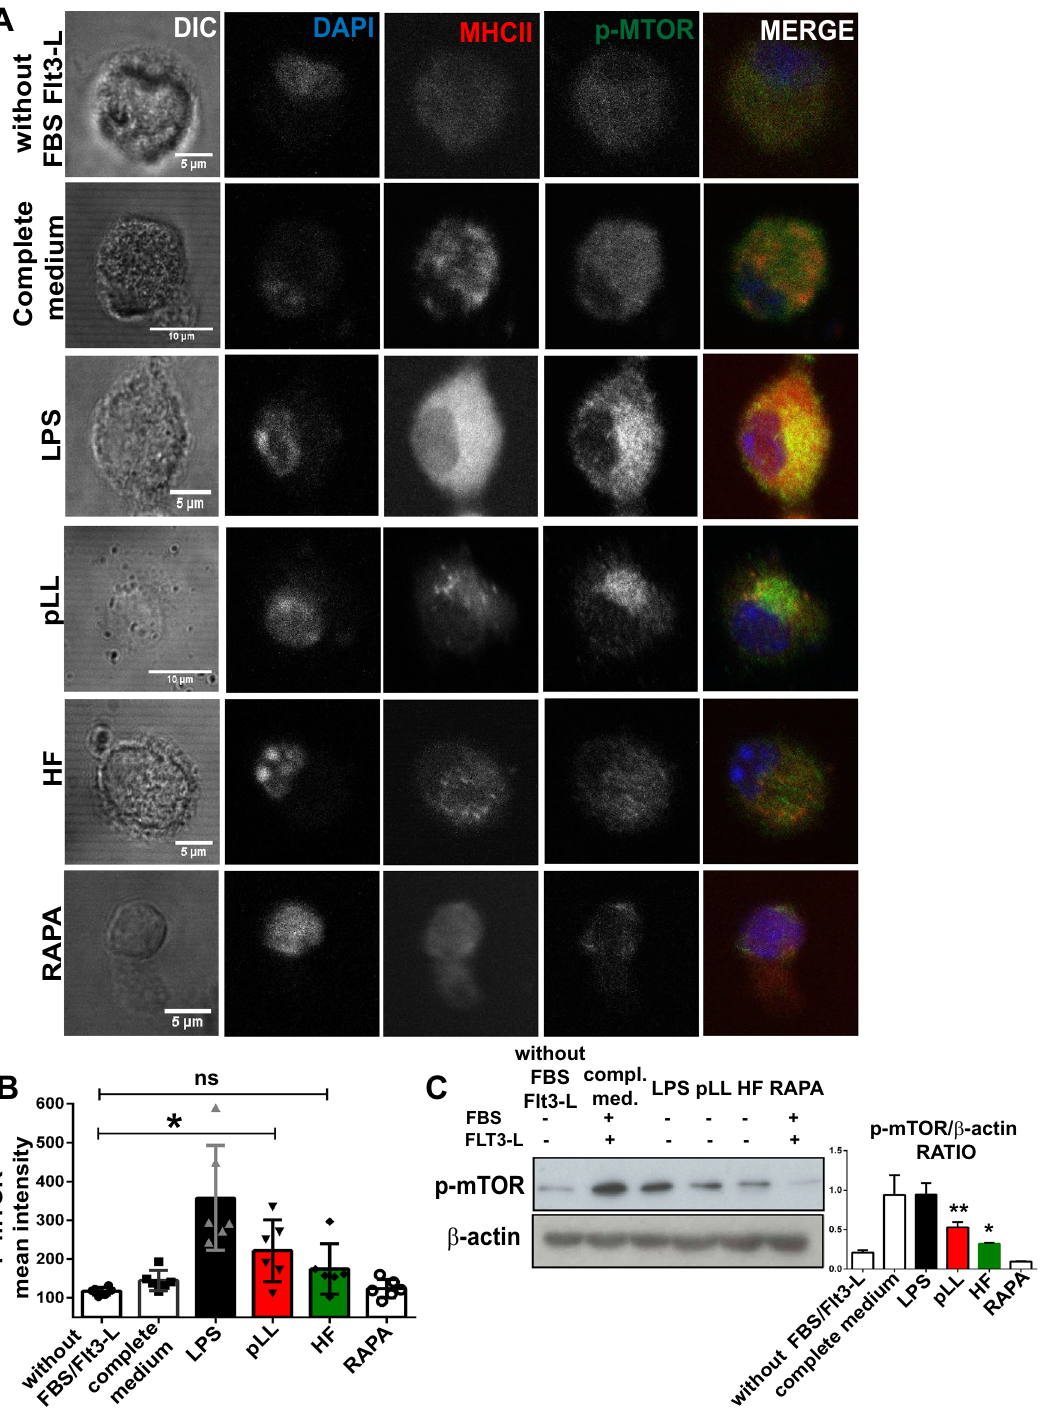
Figure 5. Purified laminar layer from Echinococcus granulosus induce the activation of mTOR complex. ( A ) BMDCs (1 × 10 6 /ml) were cultured in complete medium without FBS/Fl3T-L or stimulated for 18 h with 100 ng/ml LPS, 20 μg pLL or 5 μg HF in presence or absence of 20 nM rapamycin in growth factors depleted medium. Then, cells were stained with specific antibodies for MHC class II (red) and phosphor-mTOR (green) and visualized by confocal microscopy. Cell nuclei were stained with DAPI (blue). Scale bar 5 µm. ( B ) Bar graphs shows phosho-mTOR mean intensity ± SEM of different cells in a representative experiment of three independent experiments (one-way ANOVA test ****p < 0.0001 and Tukey post hoc test *p < 0.05, pLL- stimulated cells vs control without FBS/Flt3-L). ( C ) Immunoblot of phospho-mTOR is shown. β-actin was used for equal loading control. Phosphorylation signal was quantified with ImageJ software. Bar graphs shows phospho-mTOR/β-actin ratio ± SEM of three independent experiments (one-way ANOVA test ****p < 0.0001 and Tukey post hoc test, **p < 0.01, *p < 0.05 pLL or HF-stimulated cells vs control without